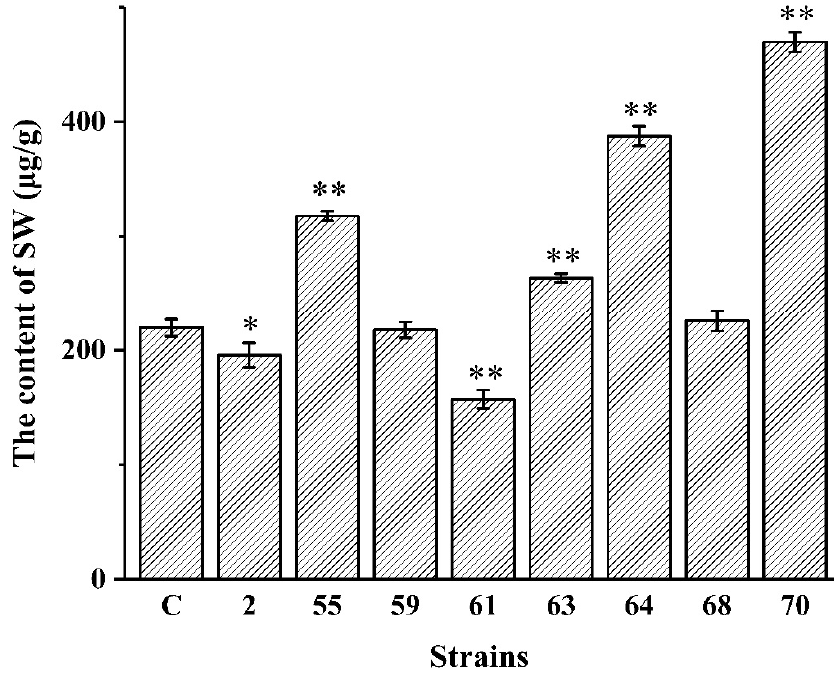
Figure 4. Cylindrical chart of the SW content of swainsonine-producing mutants by 12 C 6+ heavy ion beams. (Group C was the original strain of A. oxytropis . * p < 0.05 compared with group C, ** p < 0.01 compared with group C.).